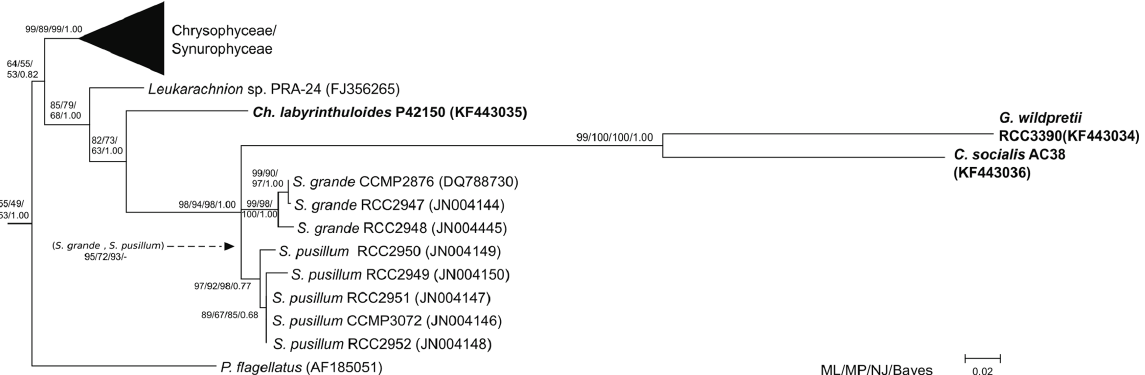
Fig 4. Phylogenetic tree of stramenopiles using 18S rDNA data to position Guanchochroma wildpretii and Chrysopodocystis socialis , Based on 78 heterokont taxa with 1506 positions and rooted with E . huxleyi . A Maximum Likelihood subtree with Synchromophyceae and related organisms is shown. Support values (bootstrap, posterior probabilities) given at nodes for all used methods. ML — Maximum Likelihood, MP — Maximum Parsimony, NJ — Neighbor Joining (K2P model), Bayes- Bayesian Analysis. Names of taxa given with corresponding accession numbers. Sequences from this study highlighted in bold, all other sequences according to dataset used by